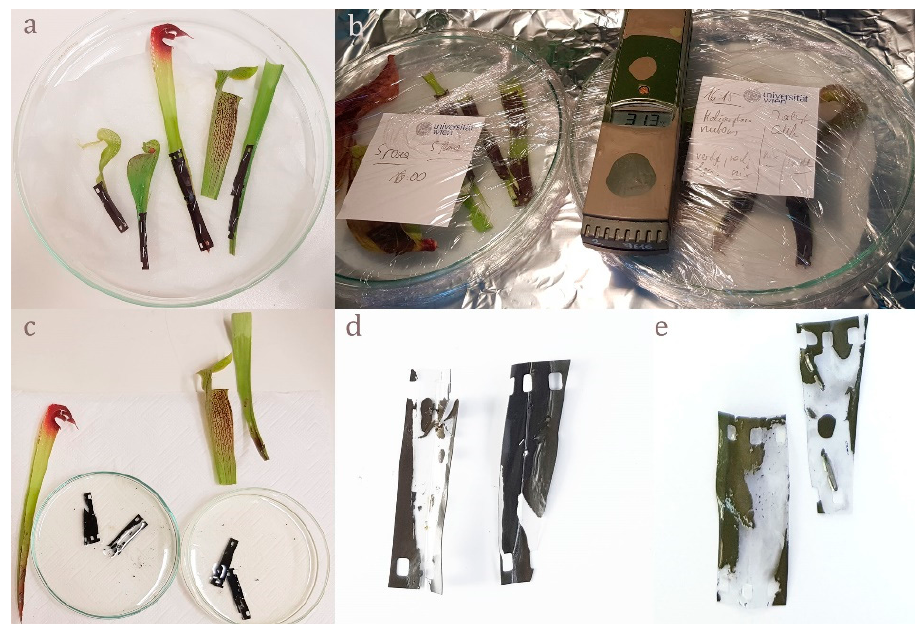
Figure 3. Enzyme test for proteases; ( a ) preparing Darlingtonia californica , Sarracenia psittacina , Sarracenia minor , and Sarracenia alabamensis for the enzyme test by attaching little pieces of film wetted with BSA onto the absorptive zones of the pitchers; ( b ) incubation in wet chambers for 18–48 h; ( c ) developing of the film pieces in a film developer; ( d ) positive enzyme test for S. minor ; ( e ) positive enzyme test for Darlingtonia californica .